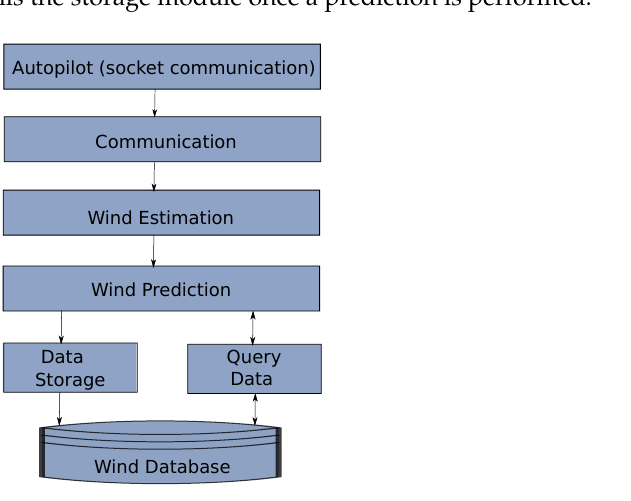
Figure 5. High level software architecture that shows the flow of information of the wind identification system.